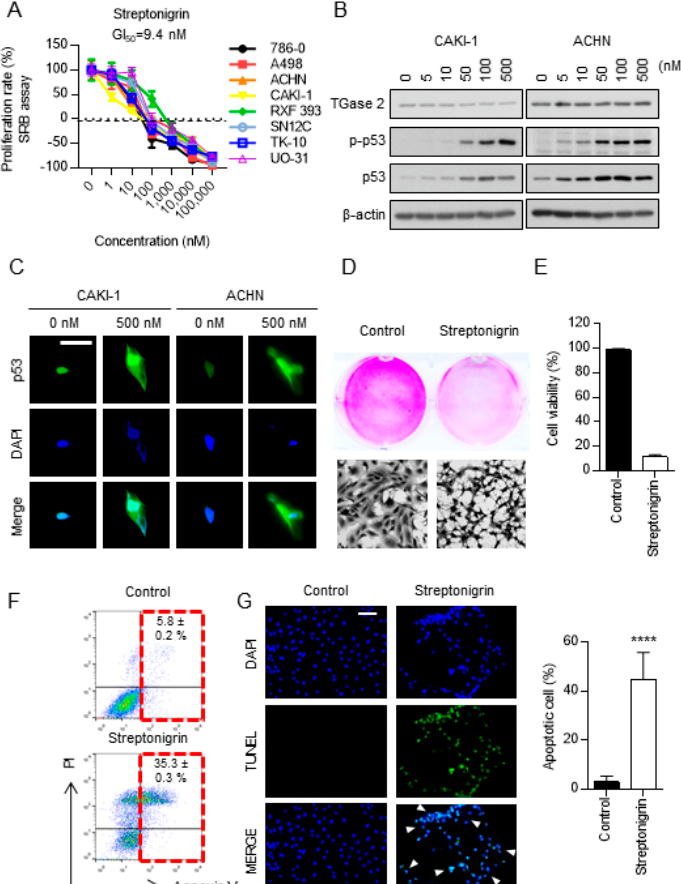
Figure 3. Streptonigrin induces apoptosis of RCC cells by stablizing p53 via TGase 2 inhibition. ( A ) The anti-proliferative activity of streptonigrin was evaluated in a sulforhodamine B (SRB) assay with a panel of human RCC cells. Cells were treated for 48 h with the indicated concentrations of streptonigrin. The GI 50 of streptonigrin was 9.4 nM. ( B ) Streptonigrin treatment (for 4 h) of CAKI-1 and ACHN cells stabilized phospho-p53 and p53 in a dose-dependent manner. TGase 2 expression was unchanged. ( C ) Immunofluorescence staining of p53 (green) in CAKI-1 and ACHN cells treated with 500 nM streptonigrin for 4 h. Images show stable expression of p53 in the presence of streptonigrin. Nuclei were stained with 4 ′ ,6-diamidino-2-phenylindole (DAPI) (blue). Scale bar = 50 μ m. ( D ) Streptonigrin suppresses proliferation of CAKI-1 cells. Cells were treated for 6 h with streptonigrin (0 or 500 nM), fixed in 4% paraformaldehyde, and stained with sulforhodamine B (SRB) (original magnification, 10×). ( E ) Viability of CAKI-1 cells treated (or not) with streptonigrin for 6 h (500 nM, n = 3) was measured in a trypan blue exclusion assay. ( F ) Cells were treated for 6 h with streptonigrin (0 or 500 nM) and stained with propidium iodide and annexin V prior to analysis by flow cytometry. LL ( lower left ), living cells; UL ( upper left ), necrotic cells; LR ( lower right ), apoptotic cells; UR ( upper right ), dead cells ( n = 3). ( G ) Cells were treated for 6 h with streptonigrin (0 or 500 nM) and then subjected to a TUNEL assay to detect apoptosis. The bar graph shows the percentage (mean ± SD) of apoptotic cells in at least five randomly selected fields of view (****, p < 0.0001). Scale bar = 100 μ m. HCT116(p53 +/+) or HCT116(p53 − / − ) cell lines were treated with streptonigrin to test whether streptonigrin-induced apoptosis depends on p53 stabilization. Streptonigrin (doses of 10 nM and above) increased expression of p53, phospho(p)-p53, p21, and BAX in HCT116(p53 +/+) cells